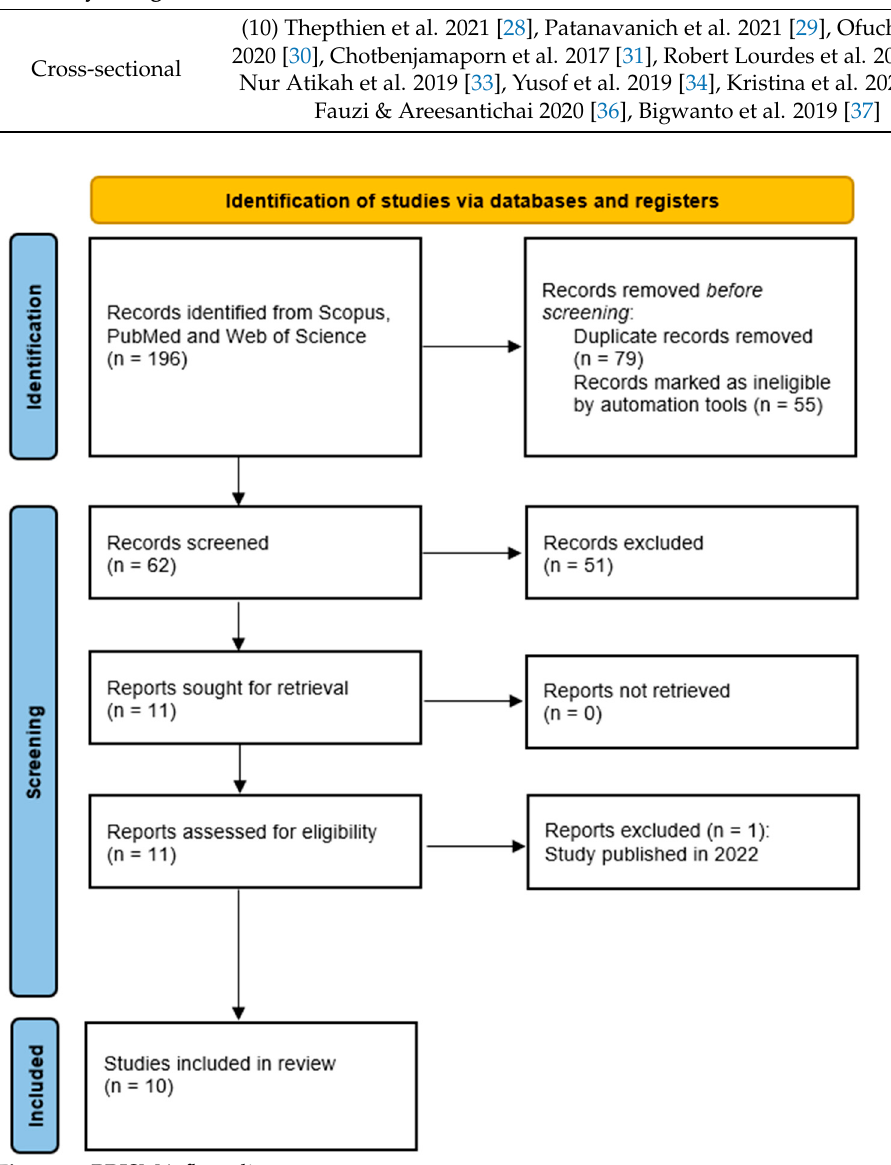
Figure 2. PRISMA flow diagram. Table 3. Summary of included